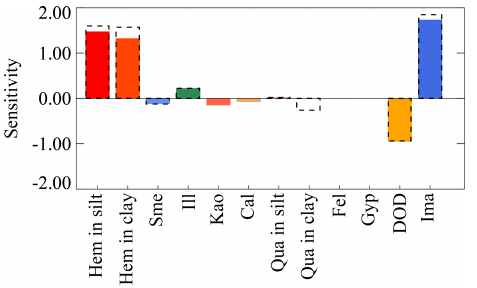
Figure 10. Sensitivity parameter (unitless) of the shortwave DRE to simulated minerals (hematite, smectite, and illite), DOD, and the prescribed imaginary complex refractive indices within the known uncertainty in CAM5. The sensitivity is measured by the ratio of the relative change in shortwave DRE to that of the parame- ter considered. Bars: values associated with higher (in color) and lower bounds (dash with opposite signs to real values) of minerals, DOD, and imaginary complex refractive index. x -axis labels: Hem – hematite; Sme – smectite; Ill – illite; Kao – kaolinite; Cal – calcite; Qua – quartz; Fel – feldspar; Gyp – gypsum; DOD – dust aerosol optical depth; Ima – imaginary complex refractive index. Sensitiv- ity for parameters other than hematite, DOD, and imaginary com- plex refractive index was derived from the “normalized” cases (see Sect. 2.3.1).